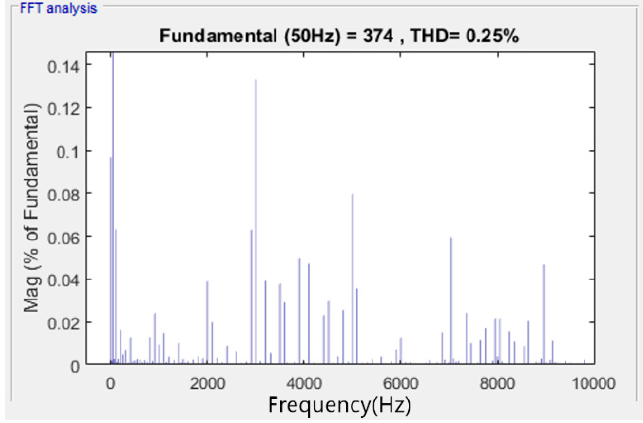
Figure 17. Three-phase four H-bridge CHB line voltage for LS PWM and non-equal sources.